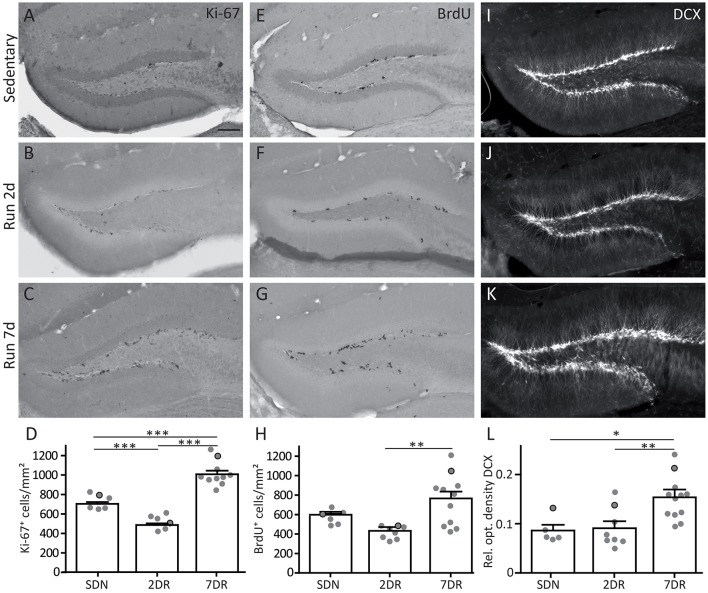
Increased neurogenesis and cell proliferation after 7 days of running is preceded by a transient decrease in proliferation. (A–C) Immunocytochemistry for the proliferation marker Ki-67 in sedentary mice (SDN, A), and in the 2 day (2DR, B) and 7 day running groups (7DR, C). Arrows mark single examples of Ki-67-positive cells. (D) Quantification of Ki-67-positive cells per area in the dentate gyrus, values are displayed as mean ± standard error of the mean (SEM). The number of proliferating cells was significantly decreased in the 2DR group compared to SDN mice (SDN N = 6, 2DR N = 7, ANOVA with Newman-Keuls post-test p < 0.001). In contrast, in the 7DR group the number of Ki-67-positive cells was significantly increased compared to both other groups (7DR N = 10, ANOVA with Newman-Keuls post-test p < 0.001 vs. SDN and 2DR). Gray dots with black frame mark the quantitative results for the mice which were selected for the immunostaining in (A–C). All immunostainings in each group stem from the same mouse, respectively. (E–G) Immunocytochemistry for the proliferation marker BrdU in the SDN (E), 2DR (F), and 7DR group (G). Arrows mark single examples of BrdU-positive cells (H) Quantification of BrdU-positive cells per area in the dentate gyrus. The pattern is comparable to Ki-67-positive cells but significance was only reached for the 7DR vs. the 2DR group (SDN N = 6, 2DR N = 8, 7DR N = 11, ANOVA with Newman-Keuls post-test 7DR vs. 2DR p < 0.01; I–K). Immunocytochemistry for DCX in the SDN (I), 2DR (J), and 7DR groups (K). Note a salient increase in DCX labeling after 7 days. (L) Densitometric analysis of DCX immunolabeling in the subgranular zone, granule cell layer and molecular layer, but sparing the hilus. DCX optical density is comparable in the SDN (N = 5) and 2DR groups (N = 8) but significantly increased in the 7DR group (N = 12, p < 0.05 vs. SDN; p < 0.01 vs. 2DR; ANOVA with Newman-Keuls post-test). Scale bar 100 μm.